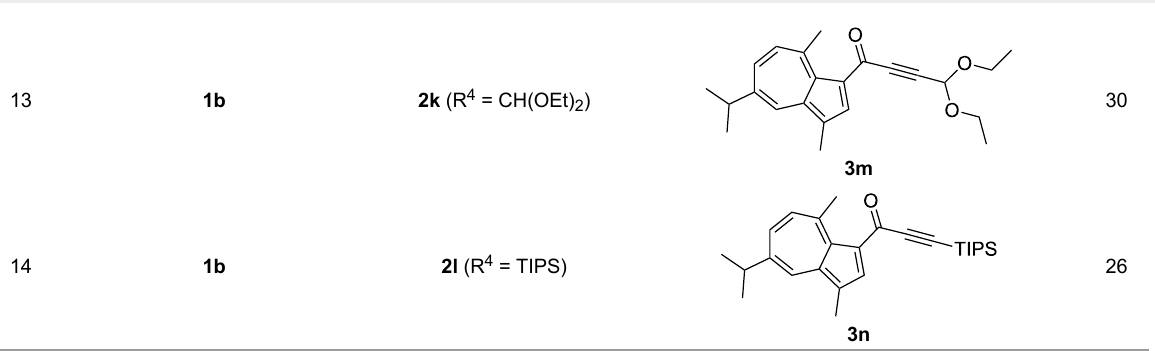
Table 2: Three-component synthesis of azulenyl- and guaiazulenylynones 3 . a